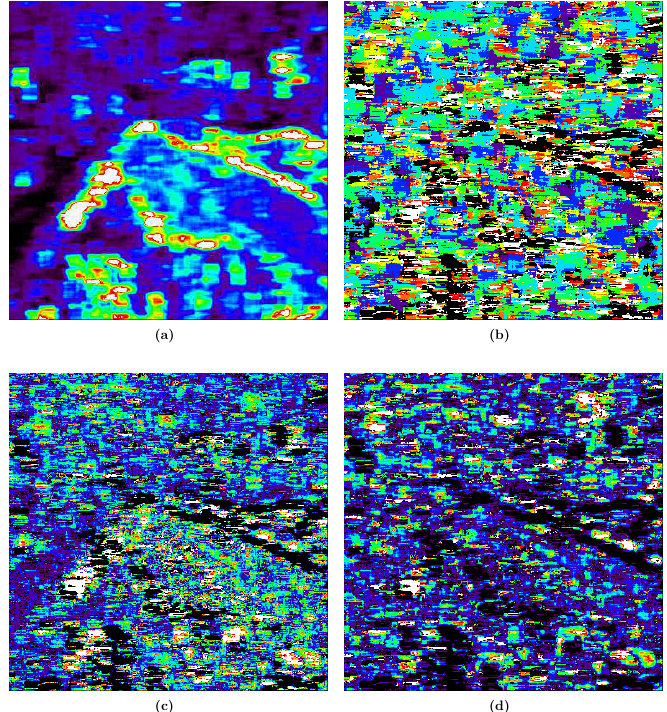
Figure 6. Vario-parameter maps resultant from classification of RADARSAT data set in Figure 3a. Based on first-order directional vario functions in 90 ◦ (north–south) direction calculated for windows of 20 by 20 pixels with offset 1 pixel. ( a ) pond; ( b ) mindist; ( c ) p1; ( d ) p2.